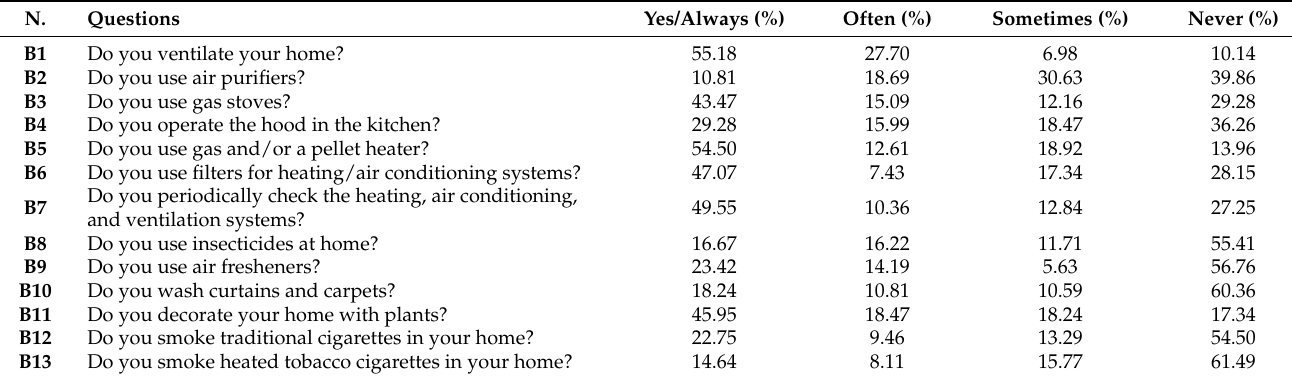
Table 4. Behaviors of respondents concerning household chemical indoor